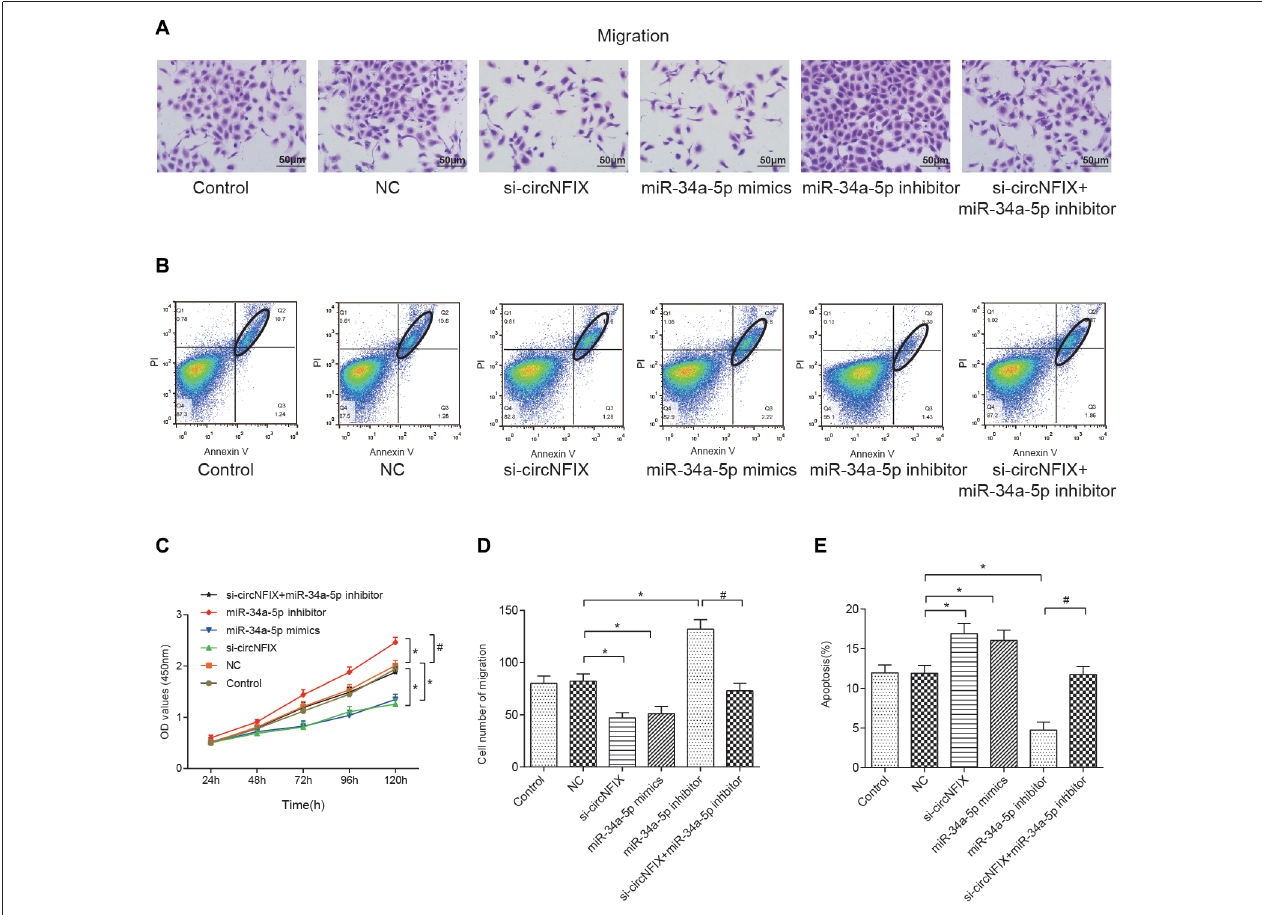
FIGURE 6 | Si-circNFIX and miR-34a-5p mimics inhibited cell migration and proliferation and promoted cell apoptosis. (A) The migration assay analyzed cell migration after the transfections. (B) Flow cytometry analyzed cell apoptosis after the transfections. Within the ellipse are apoptotic cells. (C) The CCK8 assay analyzed cell proliferation. (D) The cell migration cartogram presents cell migration levels. (E) The cell apoptosis cartogram presents cell apoptosis levels. ∗ P < 0.05 compared with the NC group, # P < 0.05 compared with the si-circNFIX group.